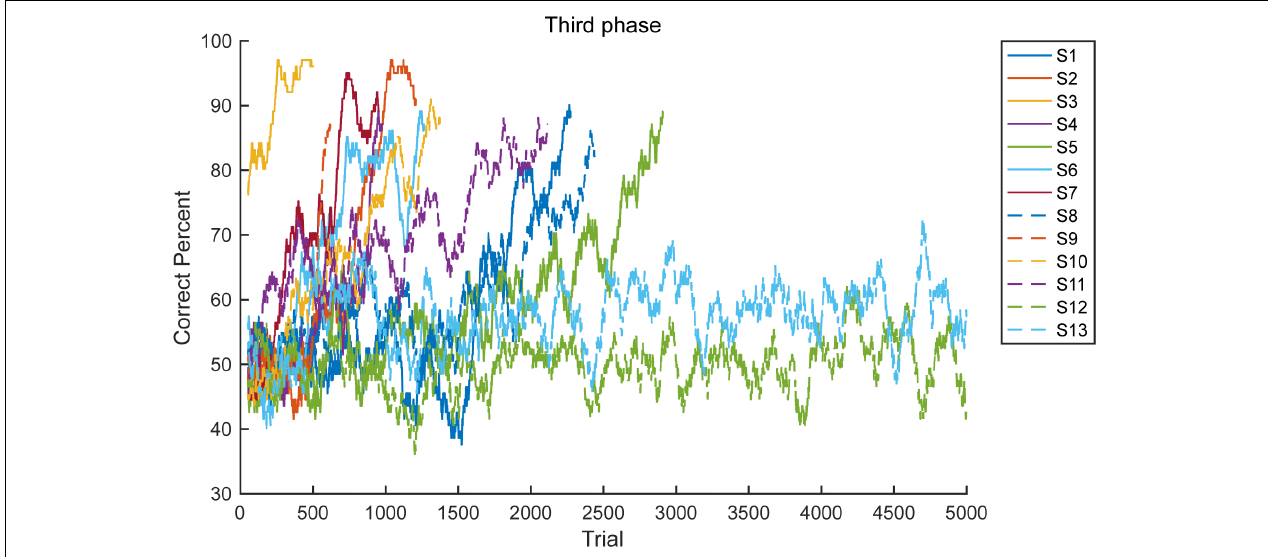
FIGURE 5 | Learning curve. Learning curves of all 13 subjects (S1–S13) in the third phase are presented. Two subjects failed to meet the proficiency criteria in 5000 trials.